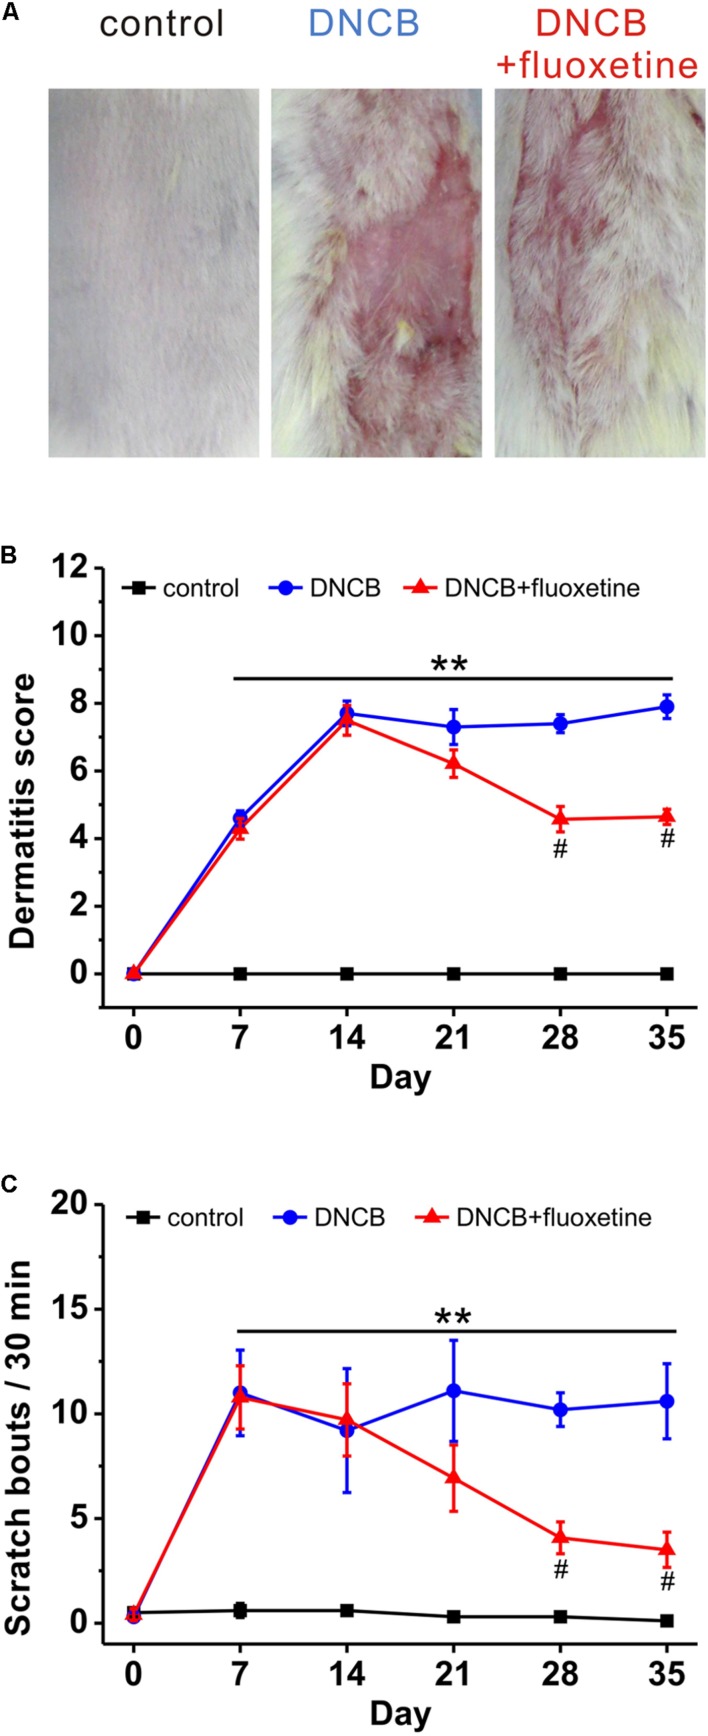
The preventive effect of chronic fluoxetine treatment on AD-like skin lesions induced by DNCB treatment.
(A) Photographs showing skin lesions in the different groups of experimental mice. (B) The severity of clinical symptoms of the skin lesions was evaluated macroscopically and calculated as the sum of the individual scores once a week for the following four AD signs and symptoms: erythema/hemorrhage, edema, excoriation/erosion and scaling/dryness. (C) The frequency of scratching behavior was observed and calculated once a week in the different treatment group. n = 10 for control and DNCB, n = 14 for DNCB+fluoxetine. ∗∗P < 0.01 compared with control, and #p < 0.05 compared with DNCB group.